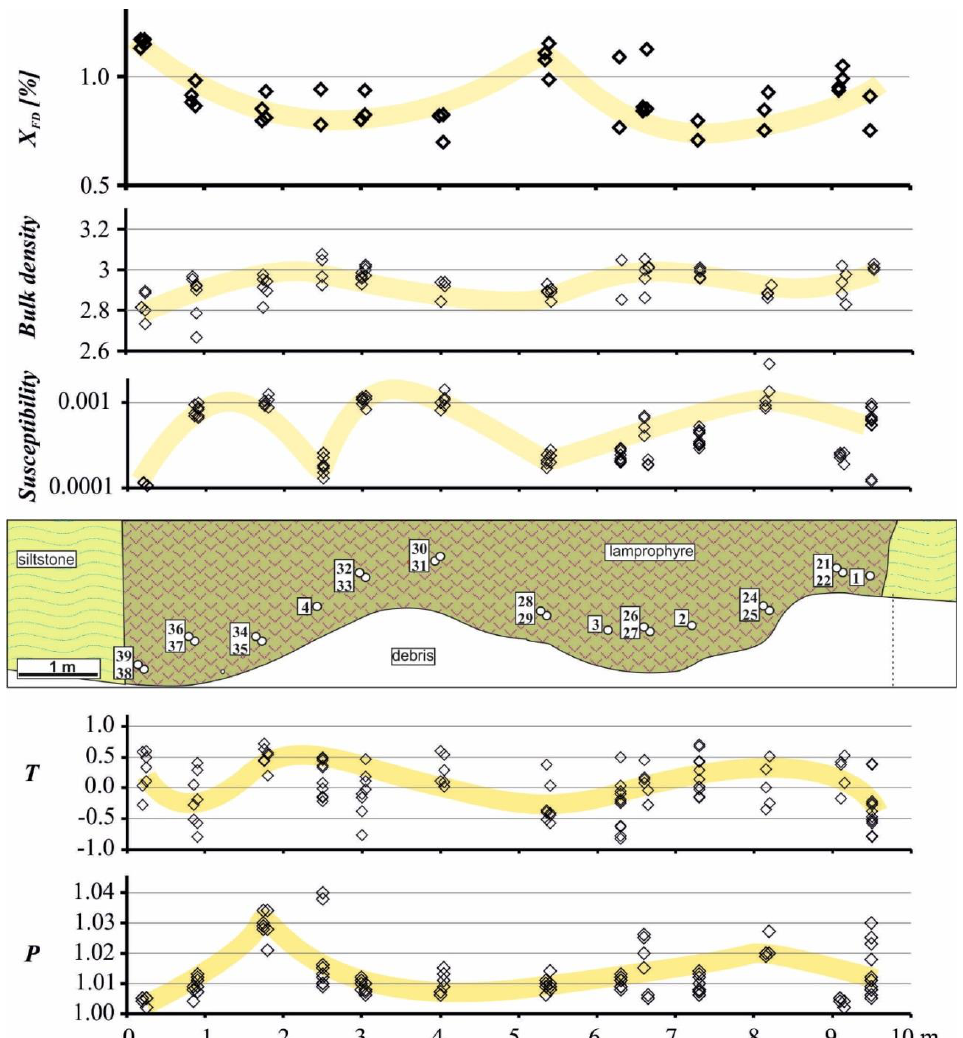
Figure 3. Sample locations (open circles with numbers 1–39), bulk susceptibility, bulk density, percentage loss of susceptibility ( X FD ), degree of anisotropy of magnetic susceptibility (AMS) ( P ), and shape parameters ( T ) within the dyke.